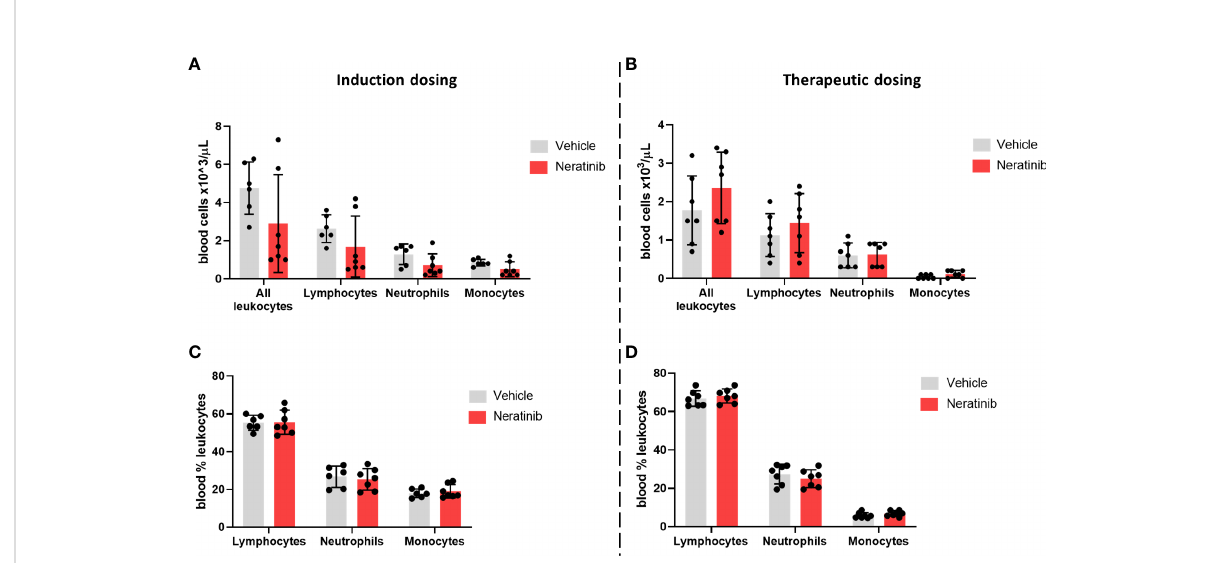
FIGURE 8 Neratinib does not alter the numbers or distribution of circulating leukocytes in chronic mouse models of lung disease. Leukocytes in mouse whole-blood samples were analyzed using an automated hematology blood analyzer, which counts total leukocytes as well as differentiates between lymphocytes, neutrophils, and monocytes; the percentages of each leukocyte subset are also analyzed. No differences in the number of leukocytes, or their subsets, were identi fi ed between the vehicle- and neratinib-treated groups in the induction dosing (A) or therapeutic dosing (B) model, and similarly, no differences in the percentages of lymphocytes, neutrophils, and monocytes were found between treatment groups in the induction (C) or therapeutic (D) dosing model. Each data point represents data from one mouse; bars show mean ± standard deviation. Unpaired t -tests were used to compare treatment groups within each cell type; p -values were indicated where appropriate.